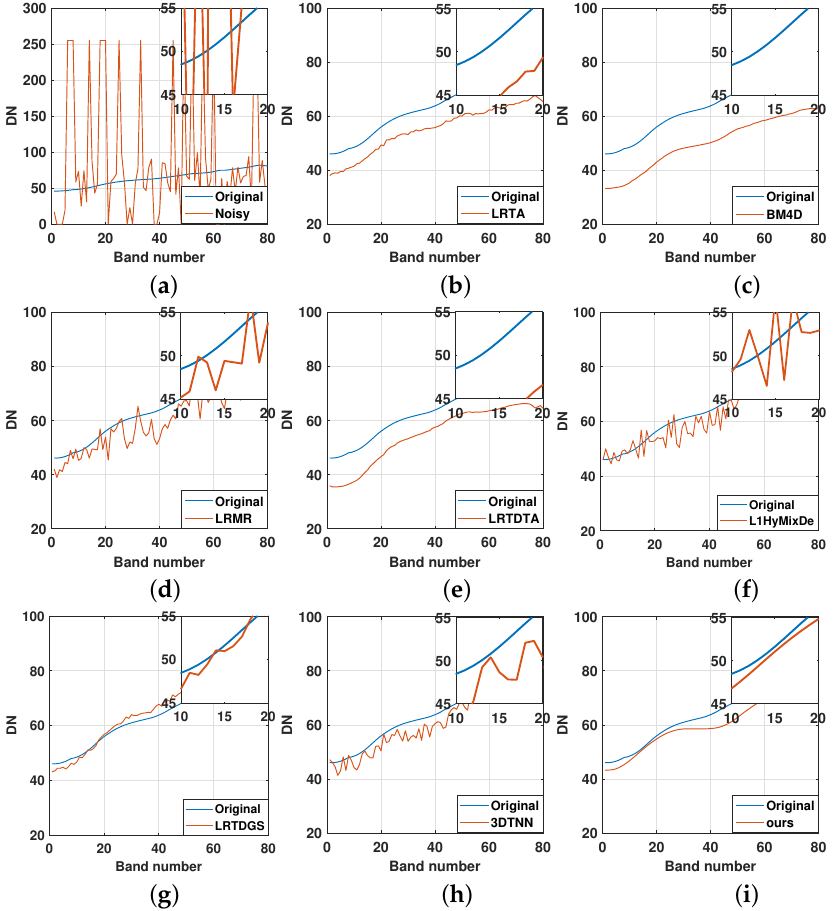
Figure 7. The reflectance of pixel (30, 30) in ( a ) noisy dataset-1, dataset-1 denoised by ( b ) LRTA, ( c ) BM4D, ( d ) LRMR, ( e ) LRTDTV, ( f ) L1HyMixDe, ( g ) LRTDGS, ( h ) 3DTNN, ( i ) ours under noise case